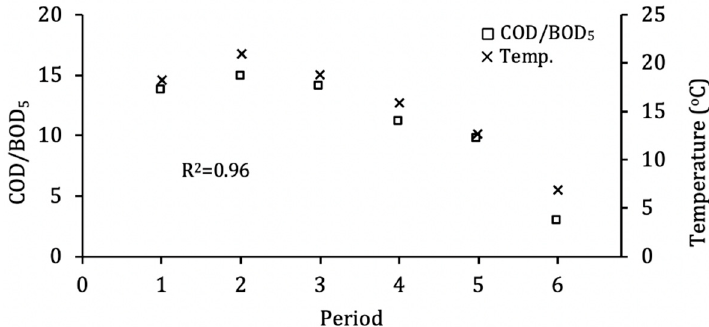
Figure 3. Correlation between COD / BOD 5 and temperature in PC over six periods.